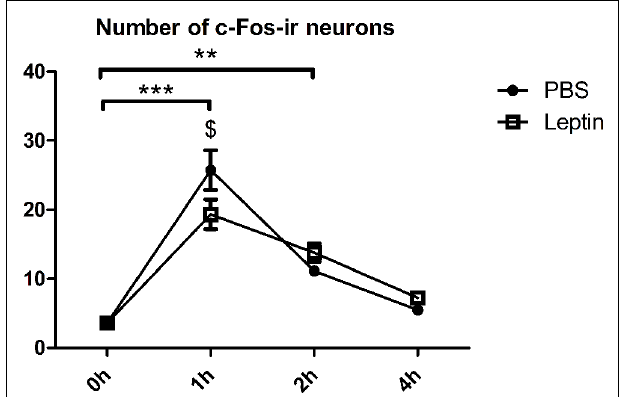
FIGURE 2 |The number of c-Fos-ir neurons in the EWcp after administration of PBS or leptin for 0, 1, 2, and 4 h. Vertical bars represent the means ± SEM; N = 4. Significant difference between groups treated for different periods with PBS and leptin is marked by “*”; significant difference between leptin and PBS group is marked by “$”. $ P < 0.05; ** P < 0.01; *** P < 0.005.